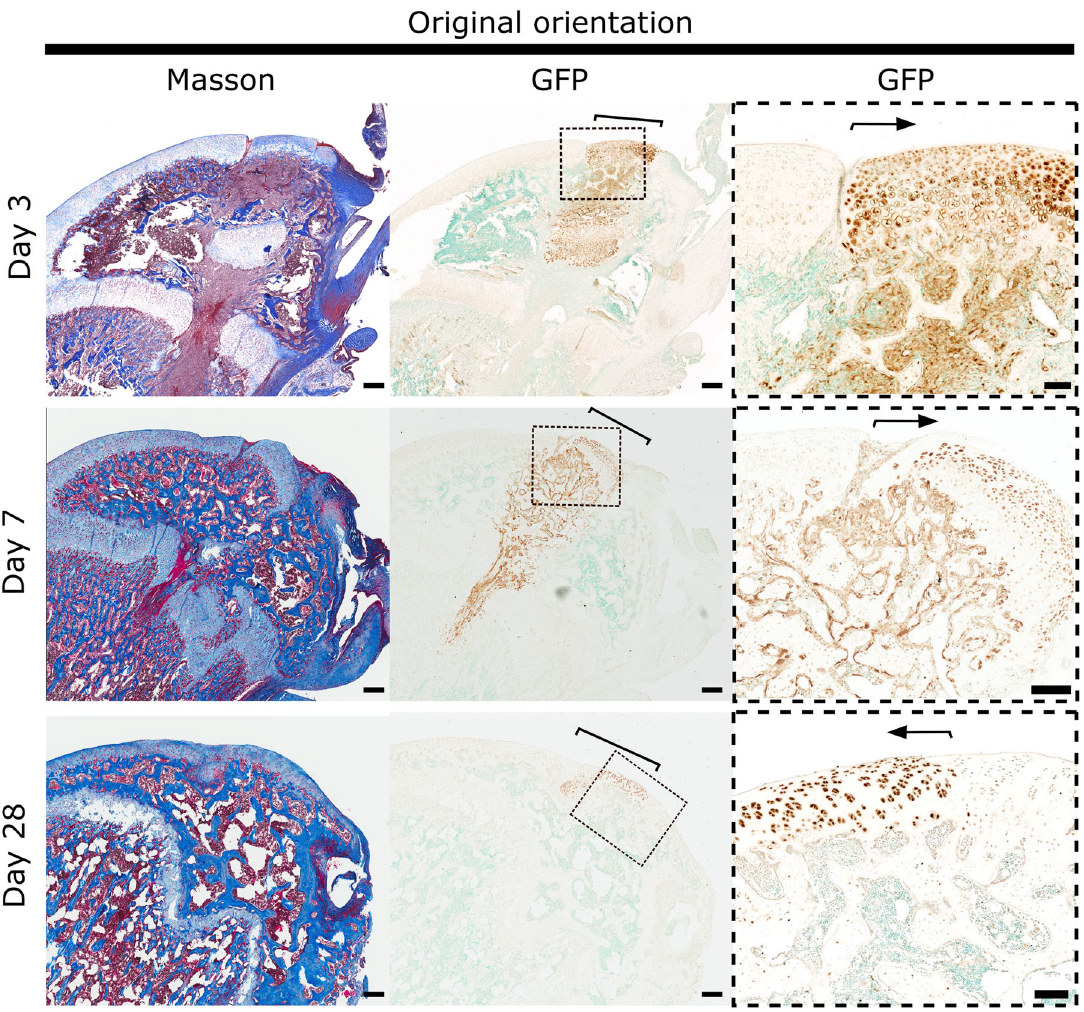
Fig. 3 Articular cartilage transplanted to the articular surface remained intact. Osteochondral allografts consisting of articular cartilage, epiphyseal bone, and growth plate cartilage were harvested from distal femurs of inbred GFP-expressing rats and transplanted to matching sites of wildtype (GFP-negative) littermates in original orientation (control). Consecutive sections of formalin- fi xed, decalci fi ed, and paraf fi n- embedded distal femoral epiphyses from GFP-negative recipient rats at postoperative day 3, 7, and 28 were stained with Masson ’ s trichrome or with GFP immunohistochemistry to localize transplanted cells and their derivatives and displayed in low (Masson ’ s Trichrome) or low and high power (GFP immunohistochemistry). Brackets and arrows delineate osteochondral allografts at the joint surface. Note that at 28 days the growth plate injury and proximal end of allograft are not visible on the imaged tissue section. Scale bar: 500 μ m and 100 μ m in low and high- power images,